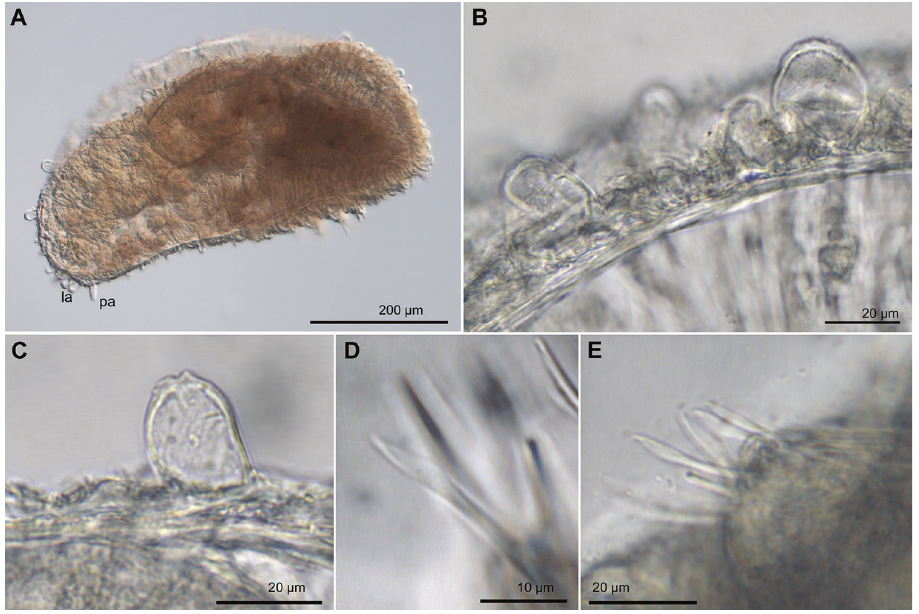
Figure 3. Euritmia carolensis sp. n., paratype, USNM 1001791, micrographs. A Whole body, side view B Dorsal papillae of different sizes, anterior segments C Detail of a large dorsal papillae D Mid-body simple chaetae E Same. Abbreviations: la, lateral antenna; pa,